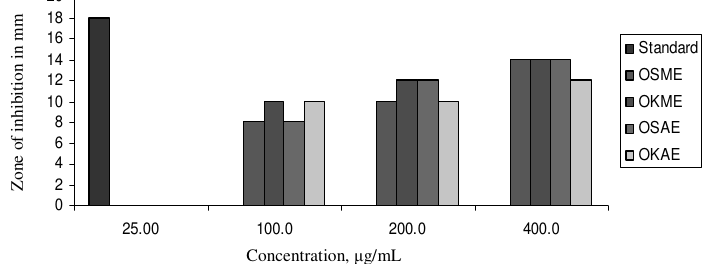
Figure 1. Antimicrobial activity of Ocimum extracts against S. aureus